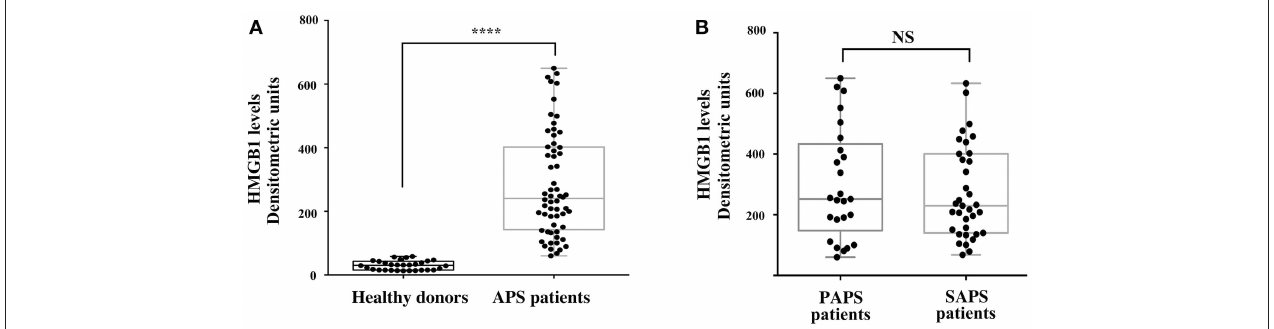
FIGURE 3 | Increase of serum HMGB1 levels in APS patients. (A) HMGB1 level were detected by Western Blot in APS patients ( n = 60) and healthy donors ( n = 30) sera, using rabbit anti-HMGB1 polyclonal Ab. Densitometric values of HMGB1 levels calculated in healthy subjects and APS patients are represented and summarized by boxplot statistics. A statistically significant difference between expression of HMGB1 in APS patients vs. control subjects was found (**** p < 0.0001). (B) Densitometric values of HMGB1 levels calculated in PAPS patients ( n = 25) and SAPS patients ( n = 35) are represented and summarized by boxplot statistics. NS, not significant.